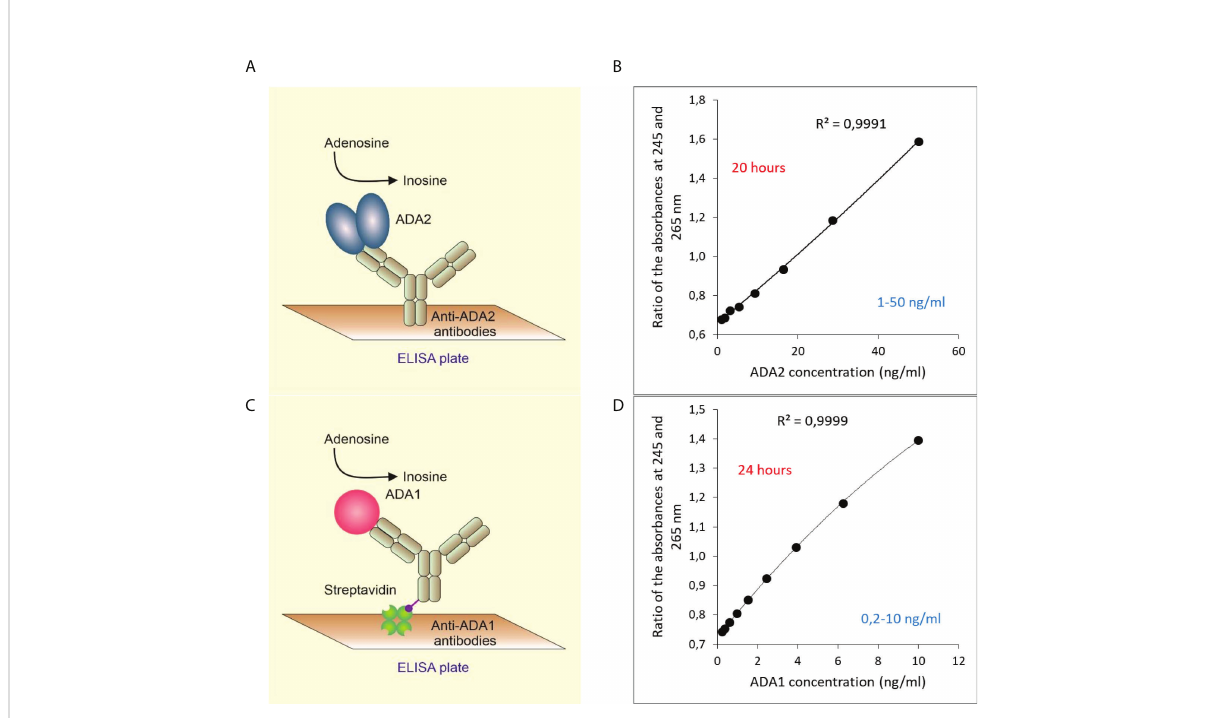
FIGURE 1 Quantitative detection of ADA2 or ADA1 in biological fl uids based on ADA activity. (A) ADA2 is captured with rabbit polyclonal anti-ADA2 antibodies following the detection of ADA activity (B) . A typical standard curve was obtained after 20 hours of incubation with 2 mM adenosine. (C) ADA1 is captured with rabbit polyclonal anti-ADA1 antibodies on streptavidin-coated plates. Then adenosine is added to detect ADA activity. (D) A typical standard curve was obtained after 24 hours of incubation with 0.3 mM